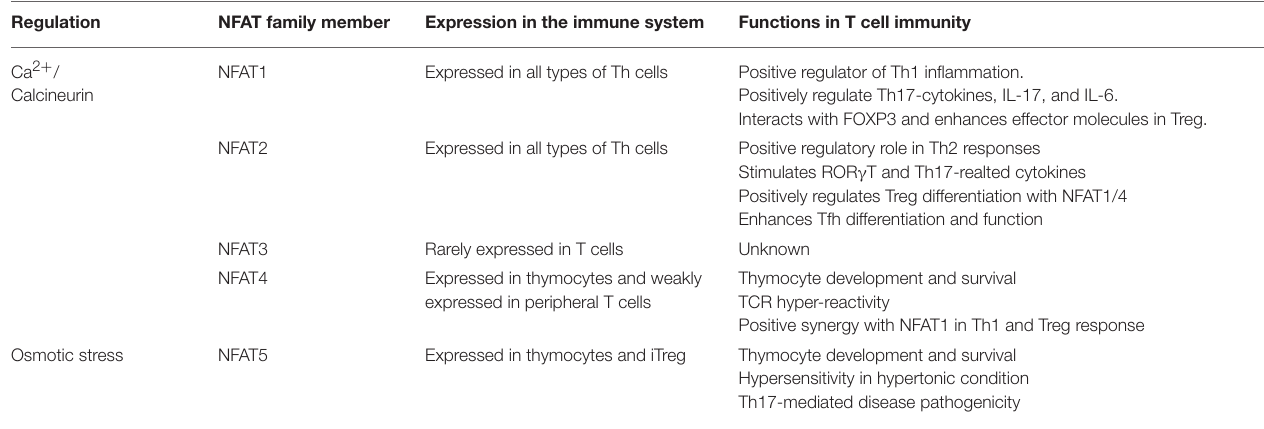
TABLE 1 | NFAT family in T cell